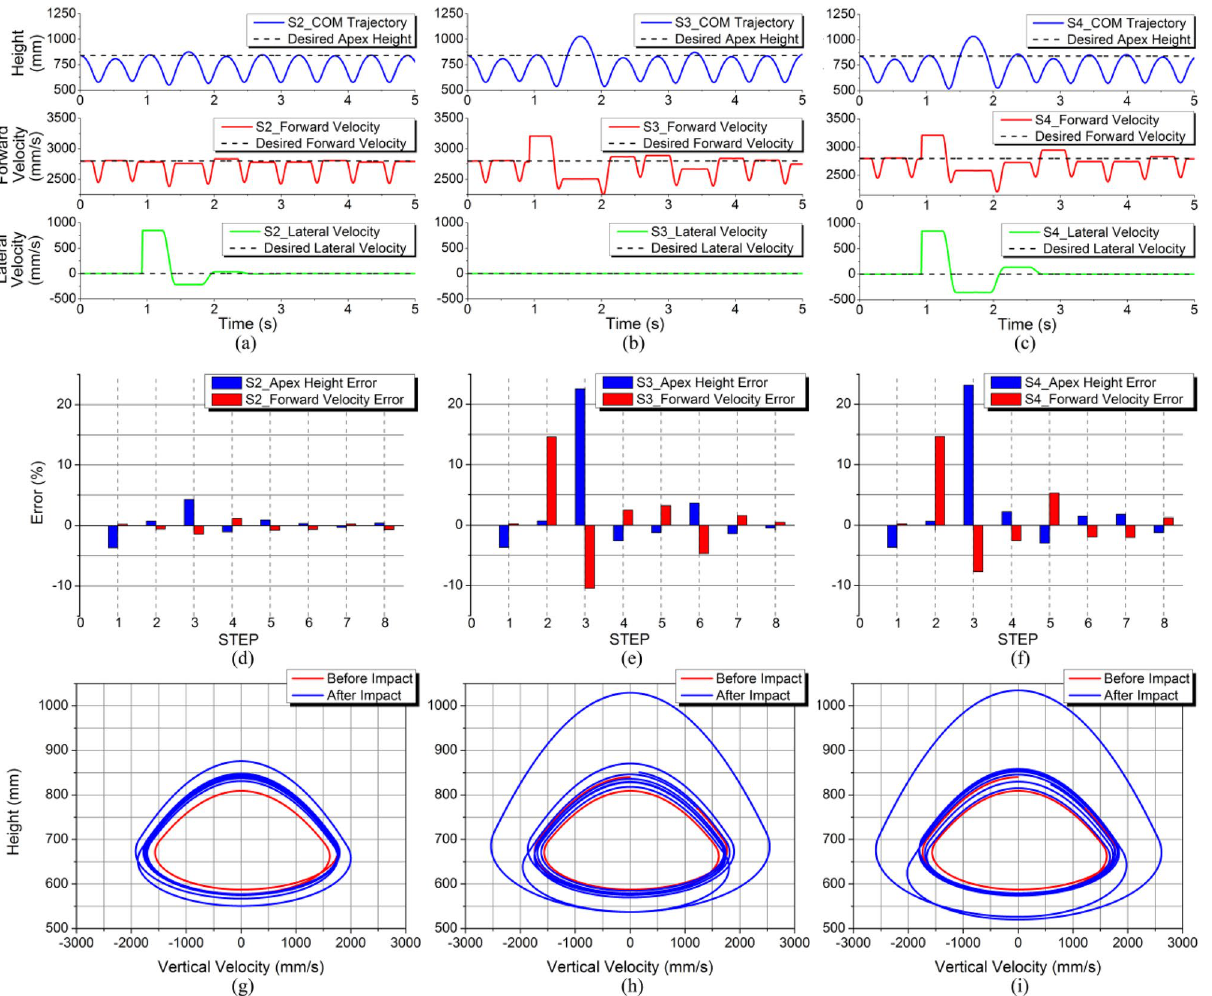
Figure 14. Simulation results for S2–S4. ( a )–( c ) Body CoM trajectory, forward and lateral velocities. ( d )–( f ) Apex height error and forward velocity error. ( g )–( i ) Phase plane trajectory.